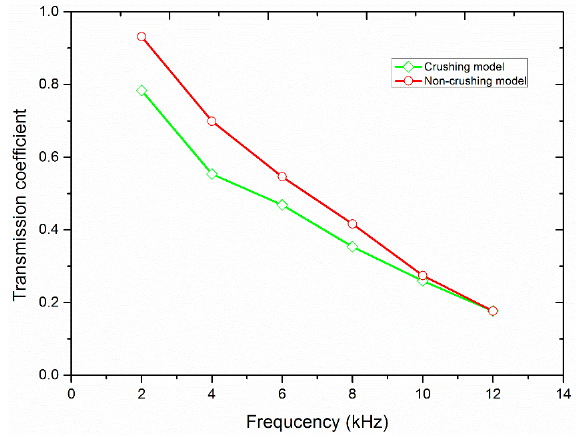
Figure 10. The variation of the transmission coefficient with the frequency of the incident wave.